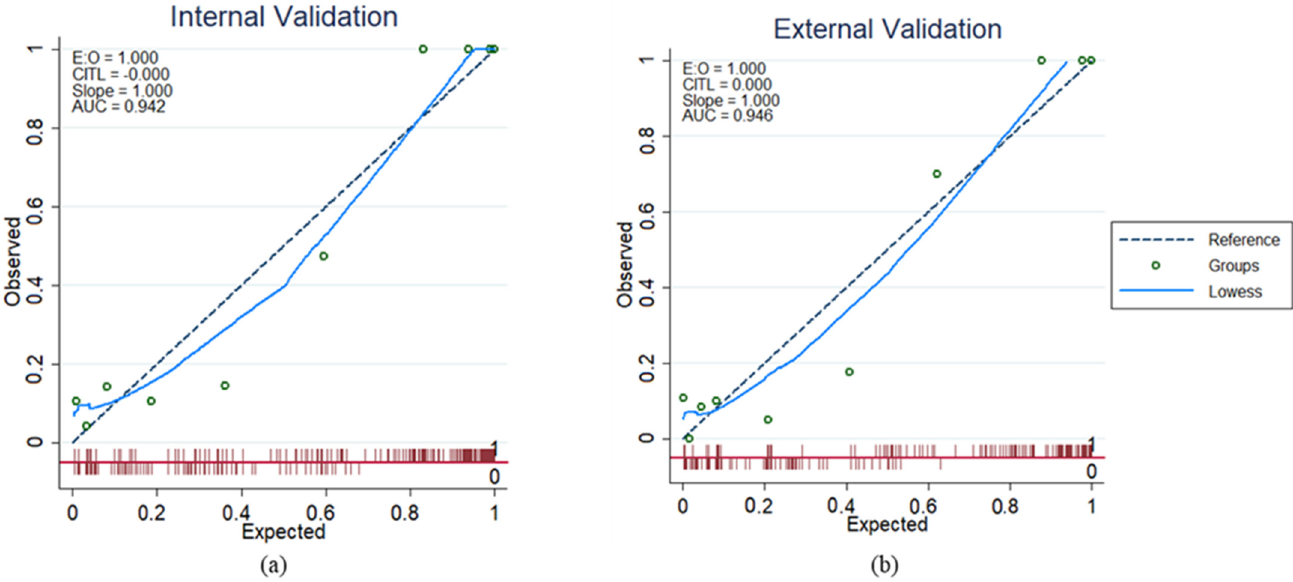
Figure 3. Calibration plot comparing actual and predicted DSPN probability for ( a ) the internal validation and ( b ) the external validation.